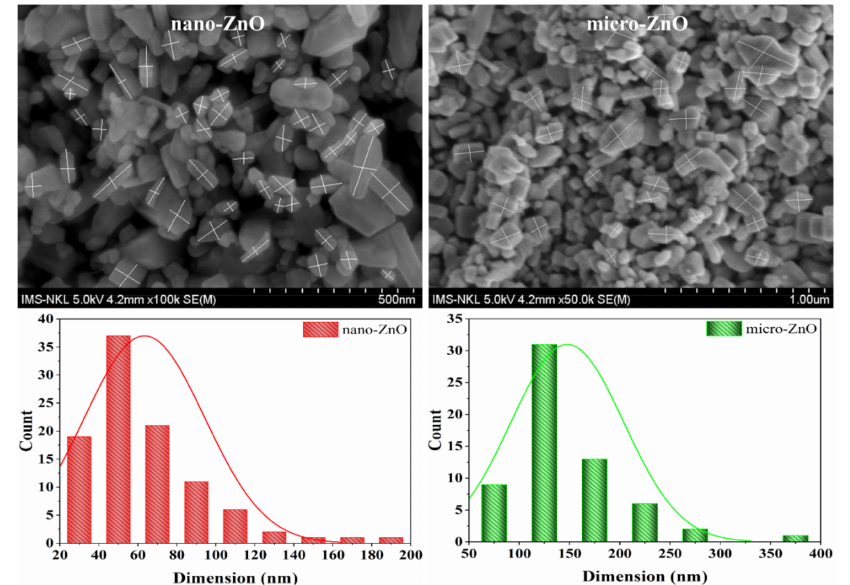
Figure 3. Marked SEM micrograph of the nano-ZnO and micro-ZnO particles for size distribution and their respective particle size distribution histograms.